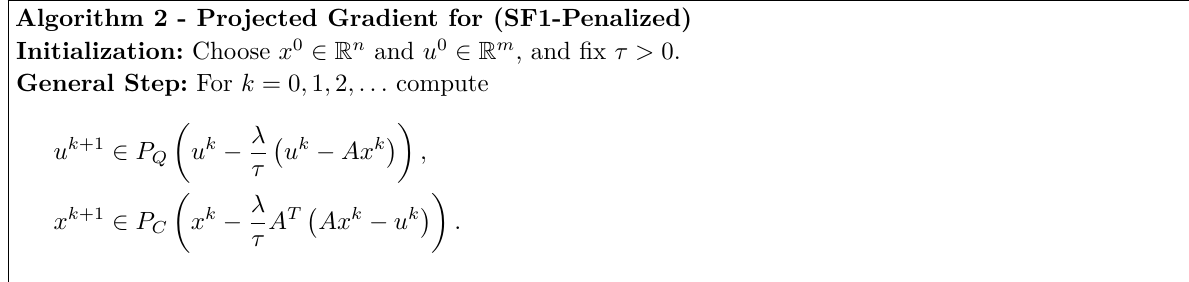
Algorithm 2 - Projected Gradient for (SF1-Penalized)